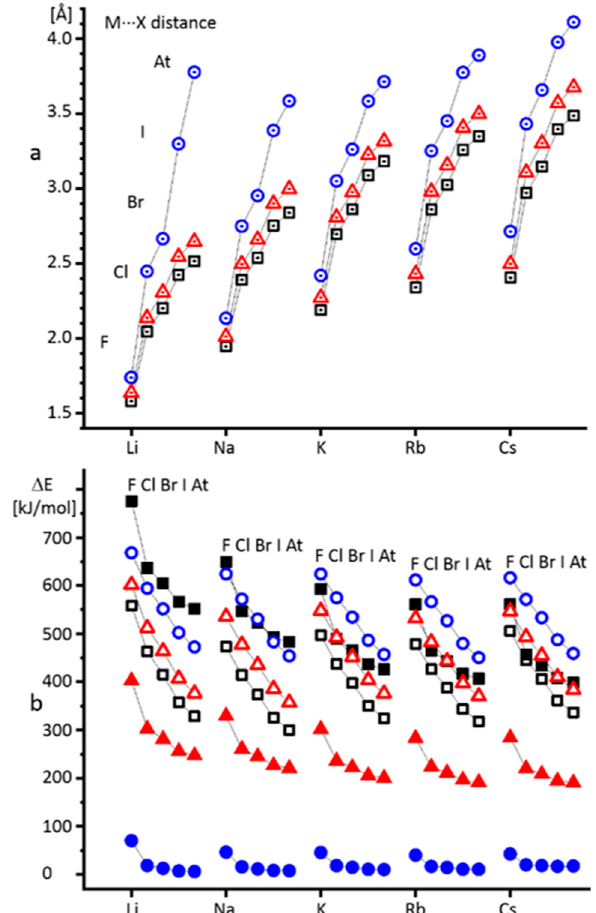
Figure 2. ( a ) Alkali metal ··· halogen distances under the gas-phase approximation ( ε = 1, black squares) and the polarizable continuum model (PCM) approximation at ε = 2 (red triangles) and ε = 100 (blue circles). ( b ) Alkali metal halide dissociation energies under the gas-phase approximation into atoms (empty black squares) and ions (filled black squares), the PCM approximation at ε = 2 into atoms (empty red triangles) and ions (filled red triangles) and at ε = 100 into atoms (empty blue circles) and ions (filled blue circles).